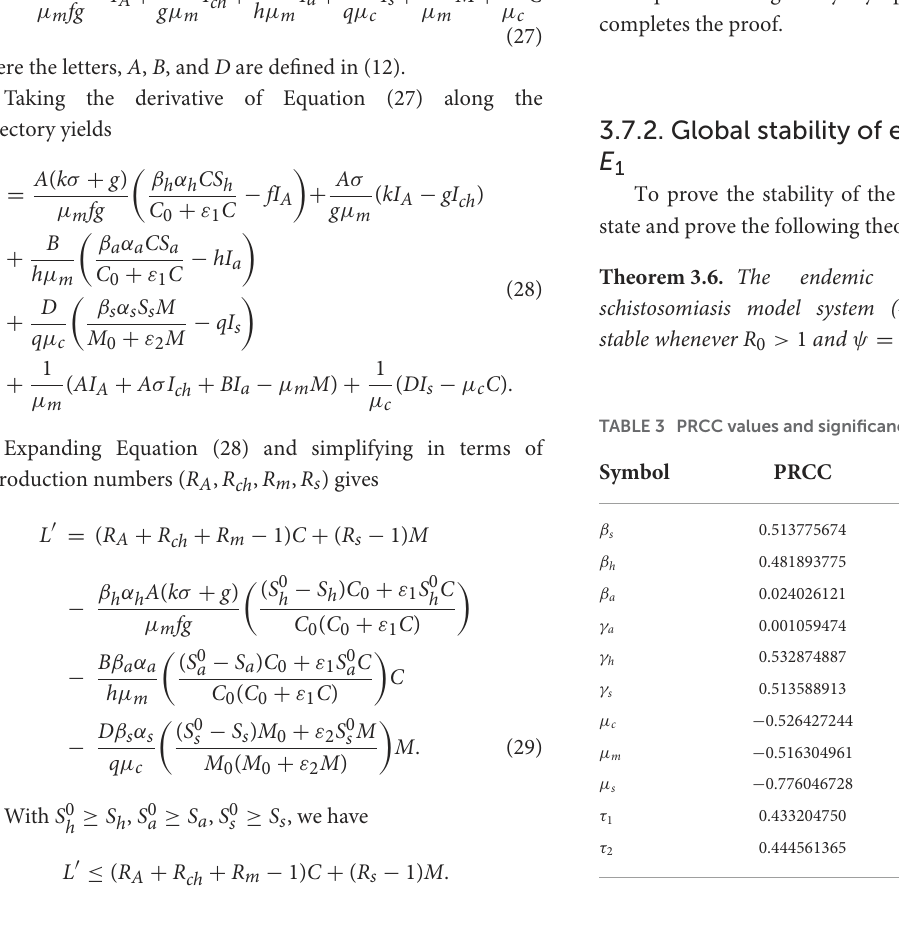
TABLE 2 Parameter values used for the numerical simulation of model system